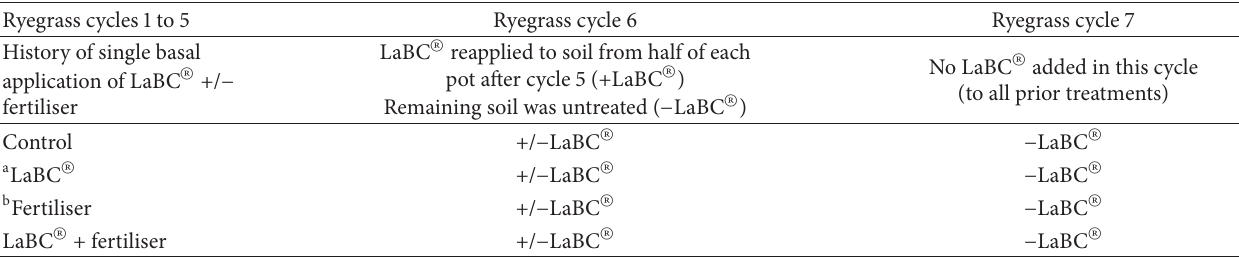
Table 2: Single basal and reapplication of LaBC Ⓡ during 7 cycles of ryegrass grown in pots of coarse-textured, acid soil under glasshouse conditions to determine the residual effects of LaBC Ⓡ